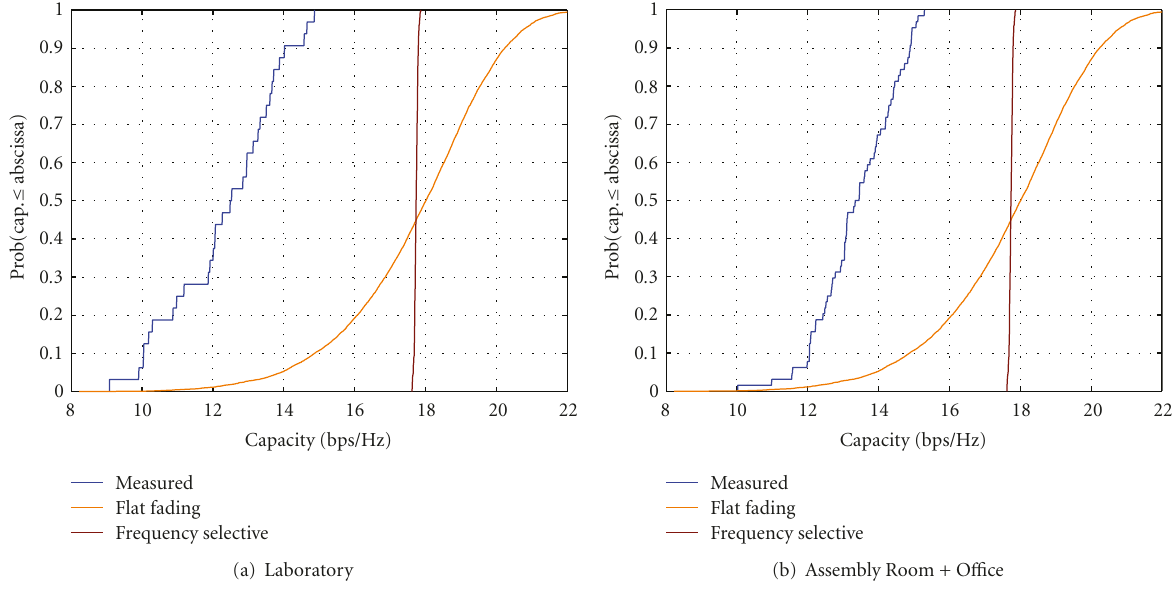
Figure 8: CDF of the MIMO channel capacity with SNR = 30dB measured and modeled in LOS areas.